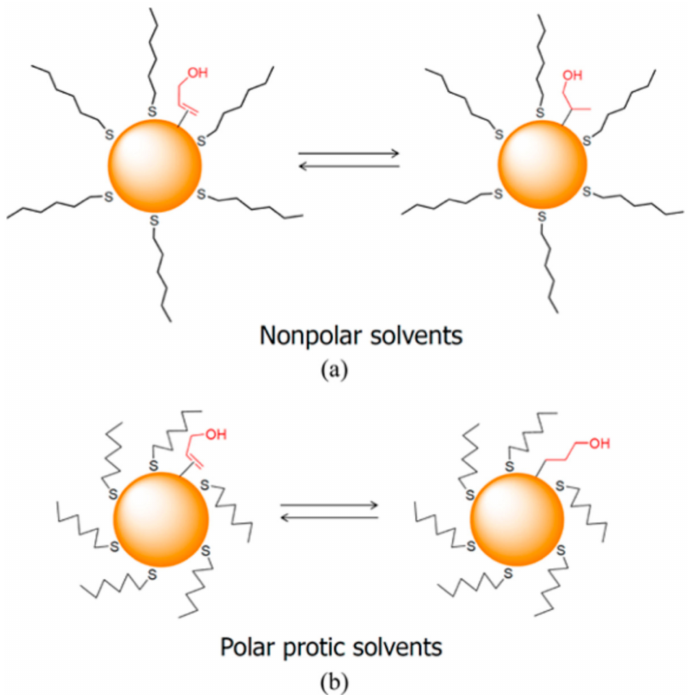
Figure 2. Isomerization and hydrogenation of allyl alcohol in nonpolar ( a ) and polar ( b ) solvents. Reproduced from Ref. [71] with permission from the American Chemical Society,